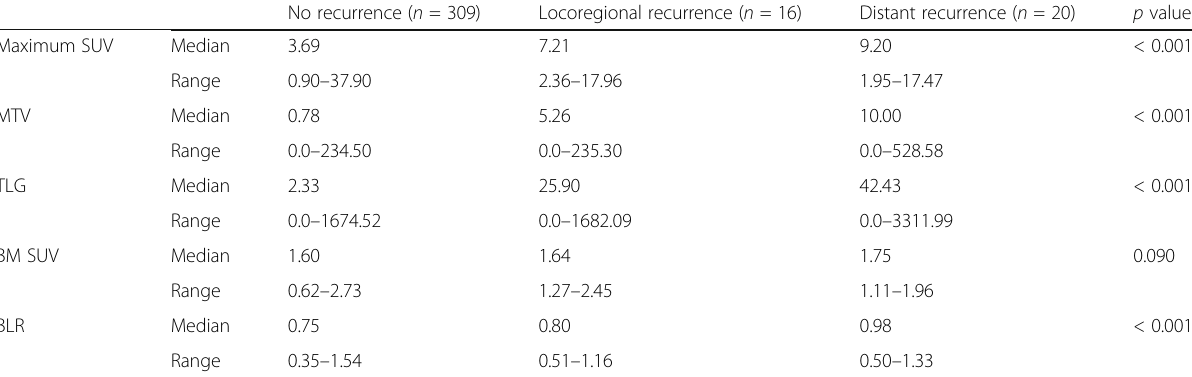
Table 2 Relationship of recurrence pattern with [ 18 F]FDG PET/CT parameters of primary breast cancer and